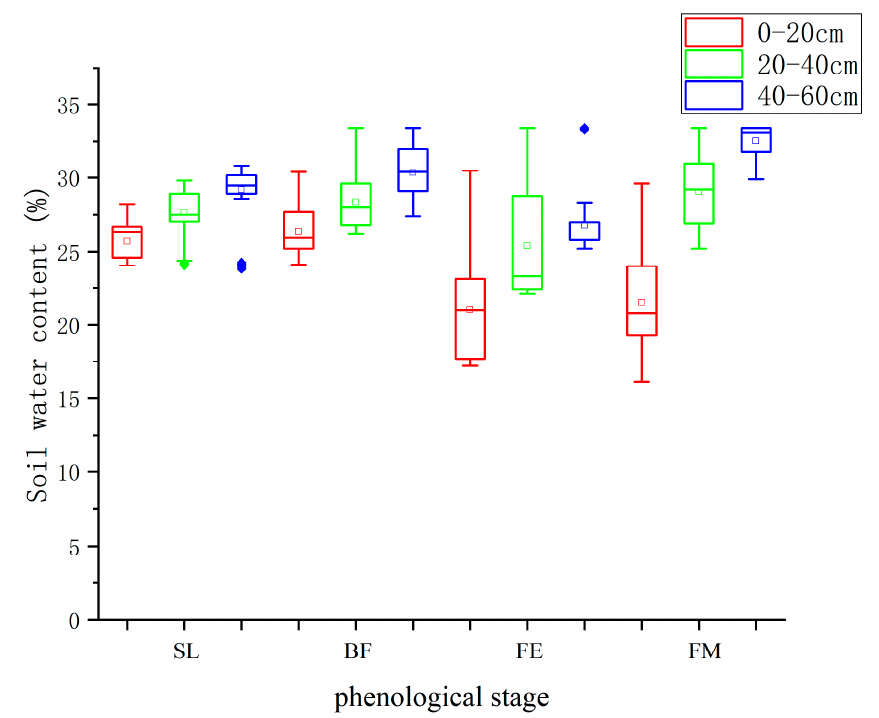
Figure 3. The soil water content during different phenological stages.